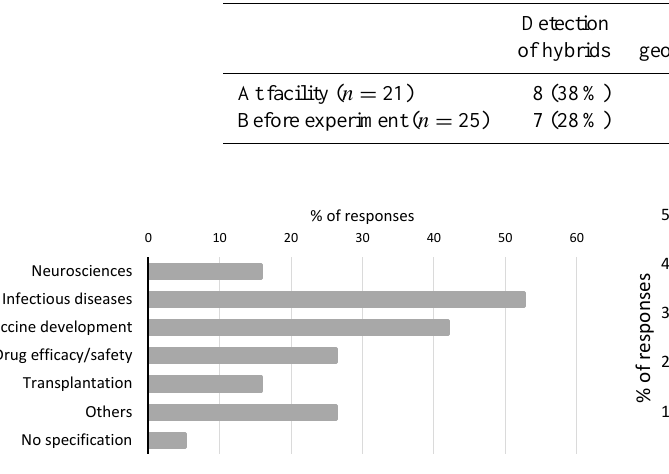
Figure 4. Genotyping frequency prior to experiments with regard to discipline ( N = 19).